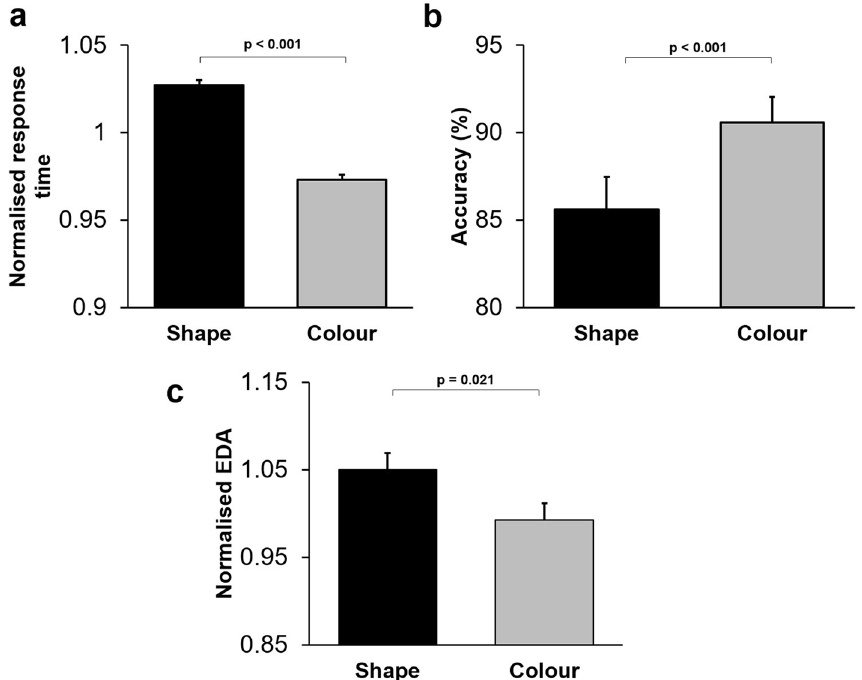
Figure 5. Dimensional bias influenced humans’ performance in the delayed matching to sample task. ( a ) Mean normalised response time is shown for colour-DMS and shape-DMS trials. Normalised response time was significantly shorter in trials when colour-matching was required than in trials when shape-matching was required. ( b ) Mean accuracy is shown for colour-DMS and shape-DMS trials. Accuracy was significantly higher in colour-DMS trials compared to shape-DMS trials. ( c ) Mean normalised amplitude of electrodermal activity (EDA) is shown for colour-DMS and shape-DMS trials. EDA was significantly lower in colour-DMS trials compared to shape-DMS